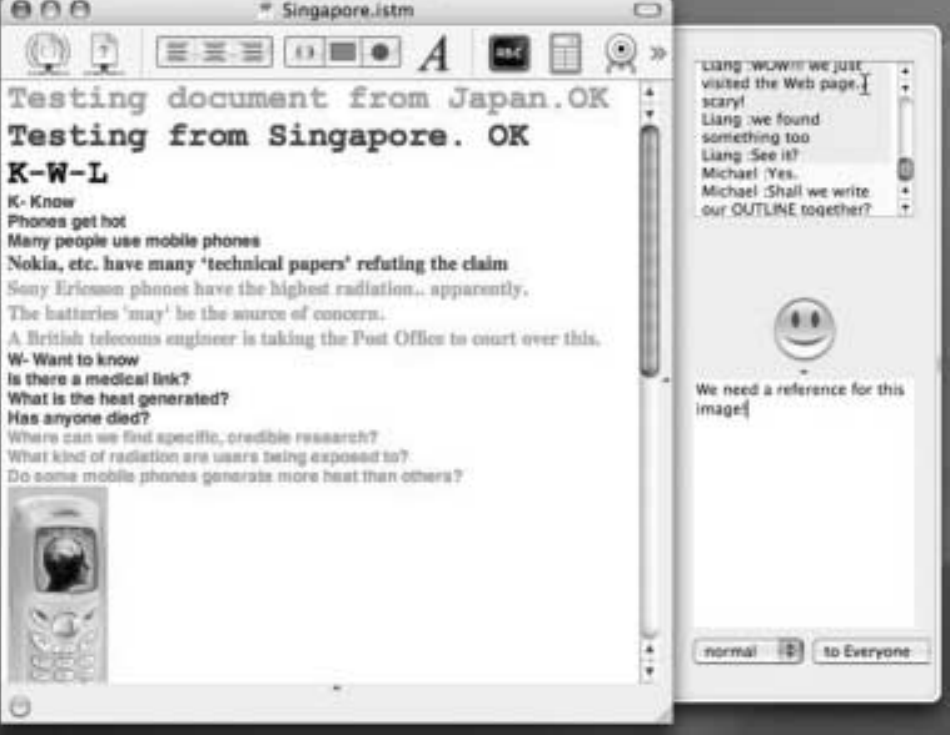
Figure 3. Synchronous